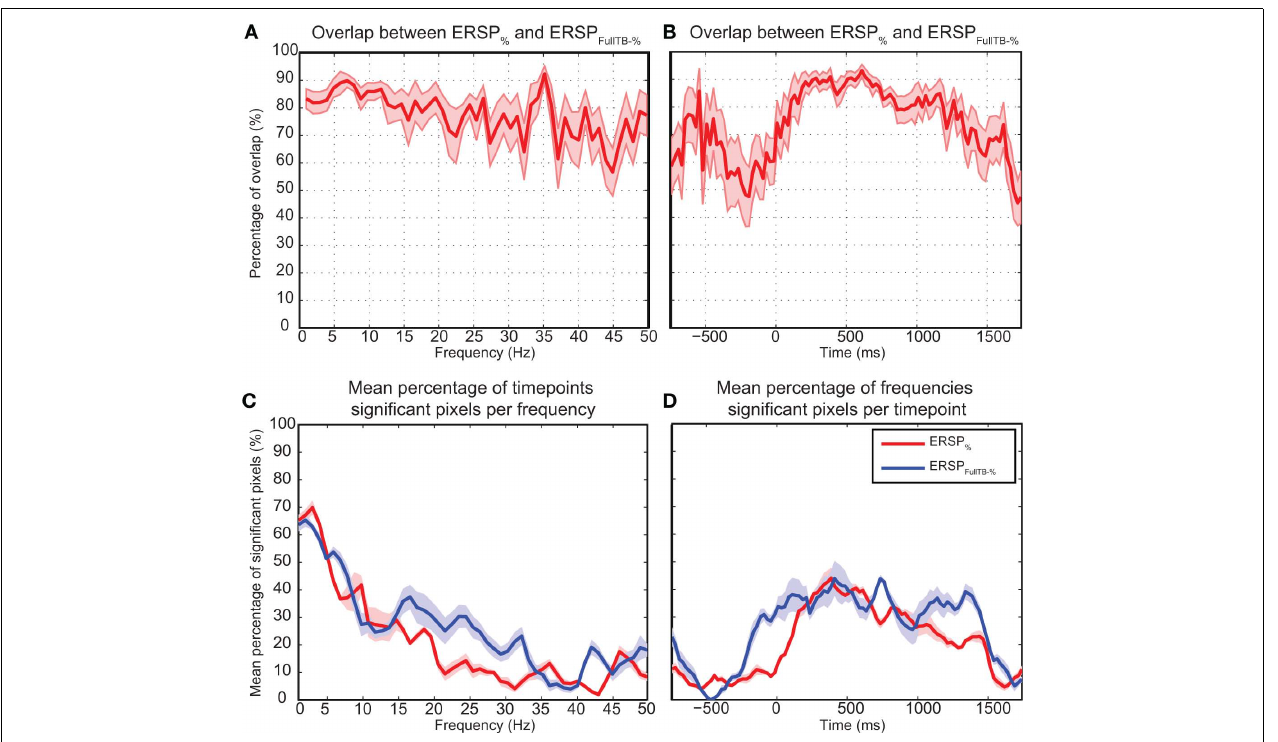
FIGURE 10 | Number of significant pixels and overlap across time and frequency for the ERSP % and the ERSP FullTB − % methods averaged over 14 subjects. The top row shows the mean percentage of overlap between significant regions of the ERSP % (classical baseline correction) and the ERSP FullTB − % (single-trial correction) methods. (A) Average overlap between